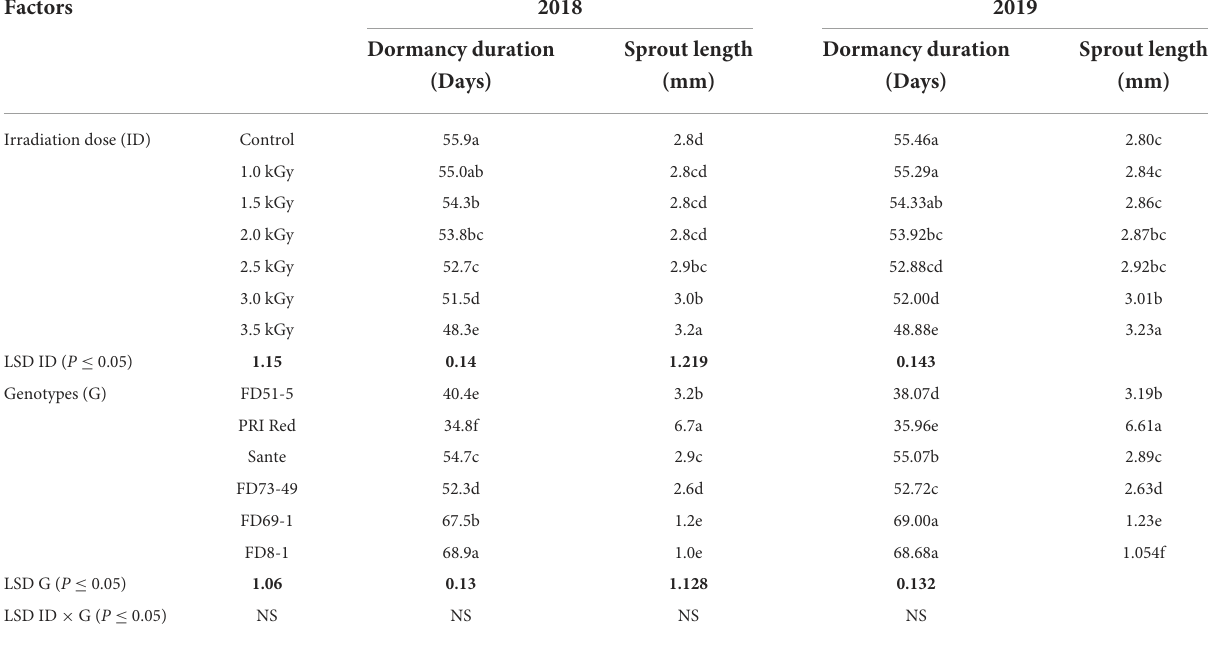
TABLE 5A Mean comparison of dormancy duration and sprout length of potato tubers for two years (2018–2019) under γ -irradiation doses and genotype main effects. Factors 2018 2019 Dormancy duration Sprout length Dormancy duration Sprout length (Days) (mm) (Days) (mm)